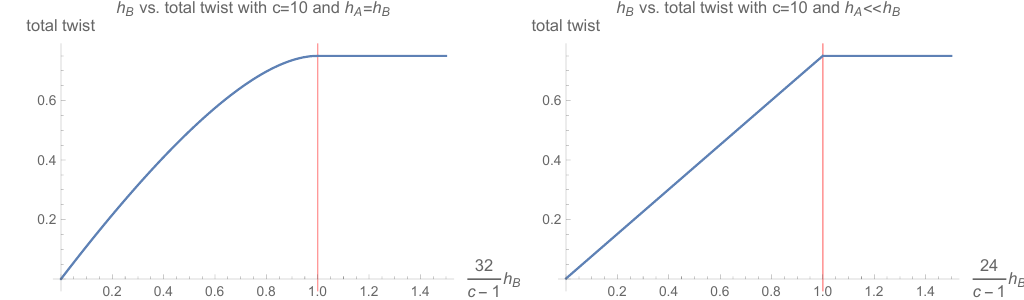
Figure 1 . The left (cid:12)gure shows the h A = h B dependence of the total twist in the OPE between O A and O B , and the right (cid:12)gure shows the h B dependence with h A (cid:28) h B . From both (cid:12)gures, we can (cid:12)nd saturation above (cid:11) A + (cid:11) B = Q . In particular, for h A (cid:28) h B , the transition (saturation) 2 occurs at the BTZ mass threshold c (cid:0) 1 . A similar phenomenon can be seen in the HHLL Virasoro 24 blocks, known as thermalisation